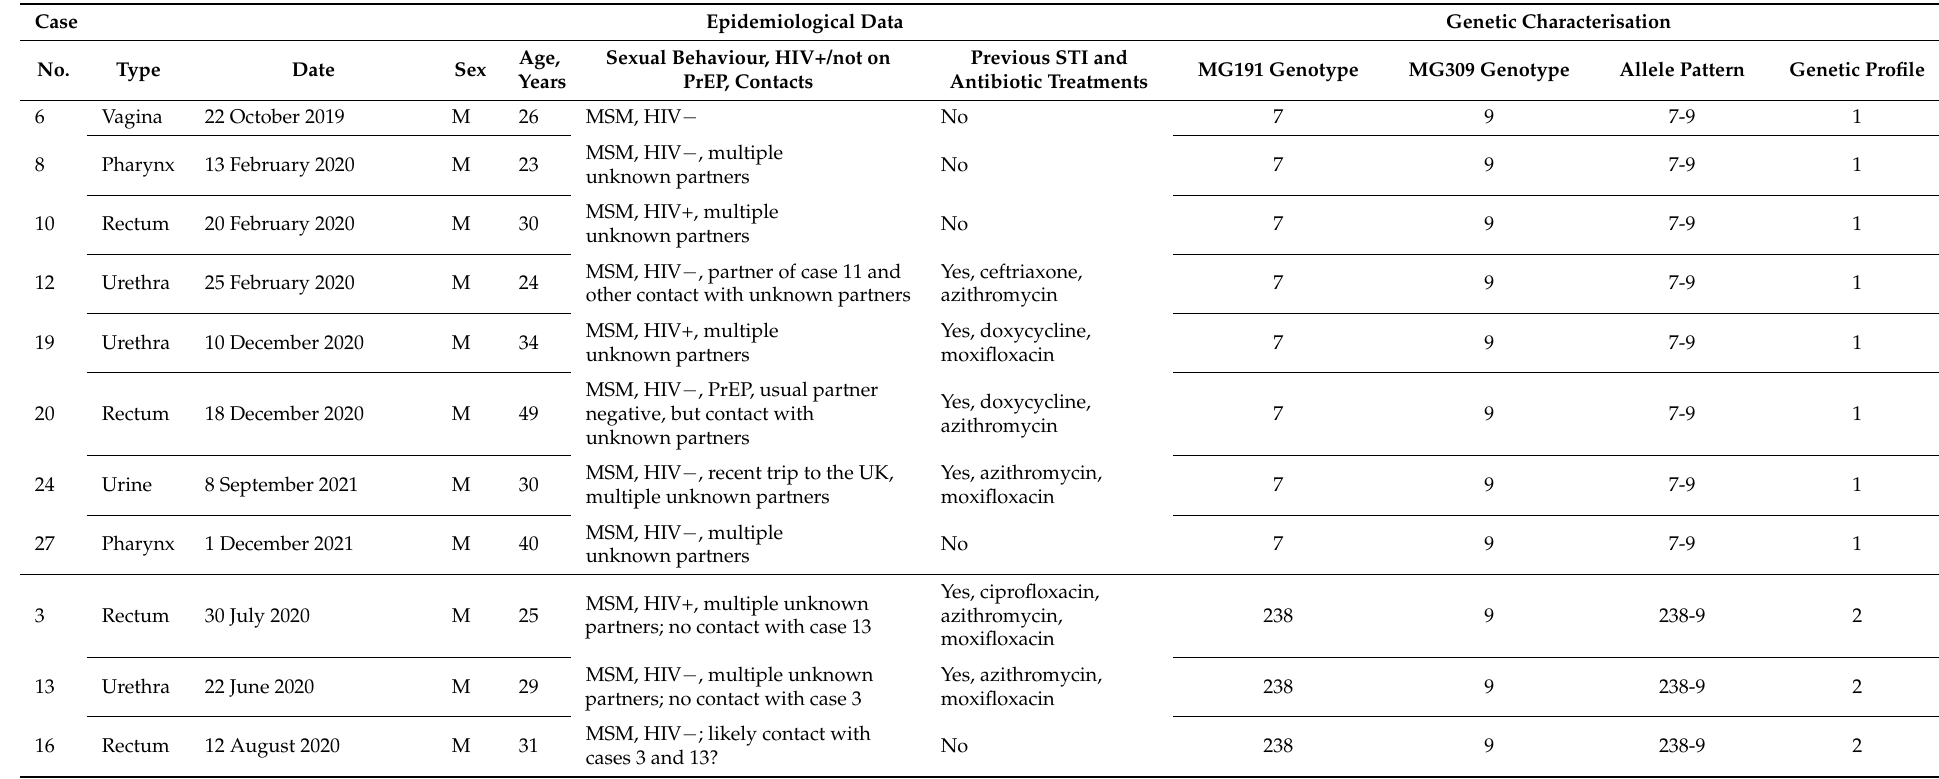
Table 2. Epidemiological and genetic characterisation data for the 27 cases of Mycoplasma genitalium infection in carriers of A2058T mutations in the. 23S rRNA gene detected in Gipuzkoa